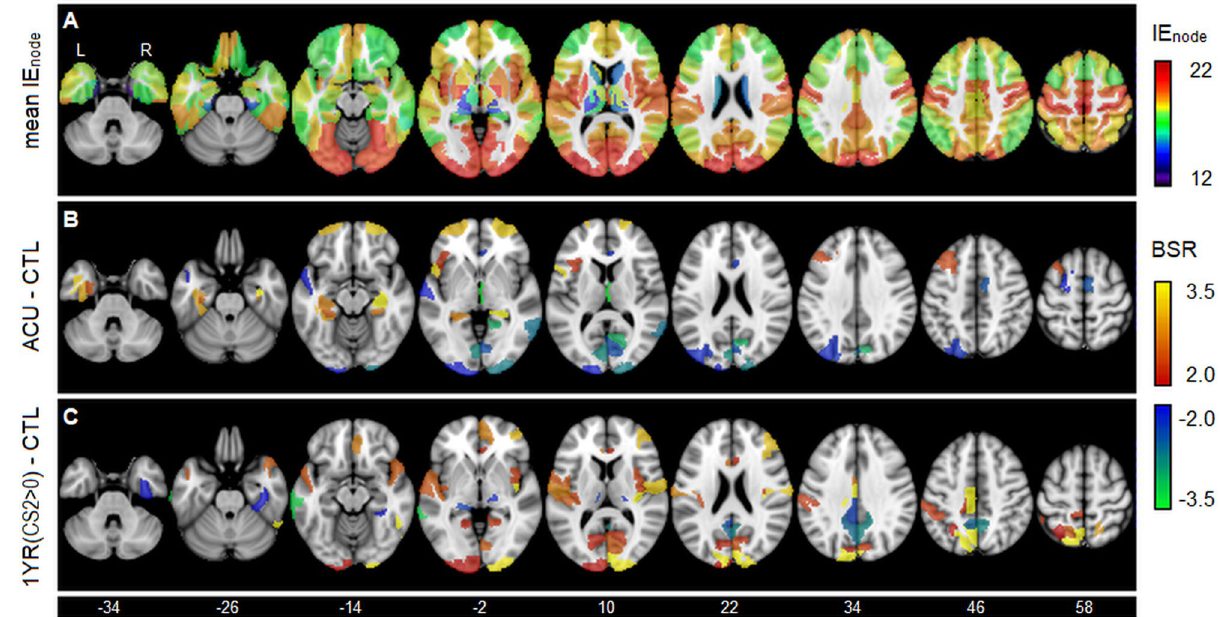
Figure 4. Localizing the effects of concussion on nodal efficiency. ( A ) The mean integrated nodal efficiency ( IE node ) values, averaged over all controls. Standardized effects sizes, reported as bootstrap ratio (BSR) values, are shown for contrasts of ( B ) concussed athletes at acute injury (ACU) relative to controls (CTL), and for ( C ) concussed athletes with clinical score CS2 > 0 at one year post-RTP (1YR) relative to controls (CTL). Maps are thresholded at |BSR|> 2, equivalent to p < 0.05 uncorrected, and the z-axis coordinates of axial slices in MNI space are